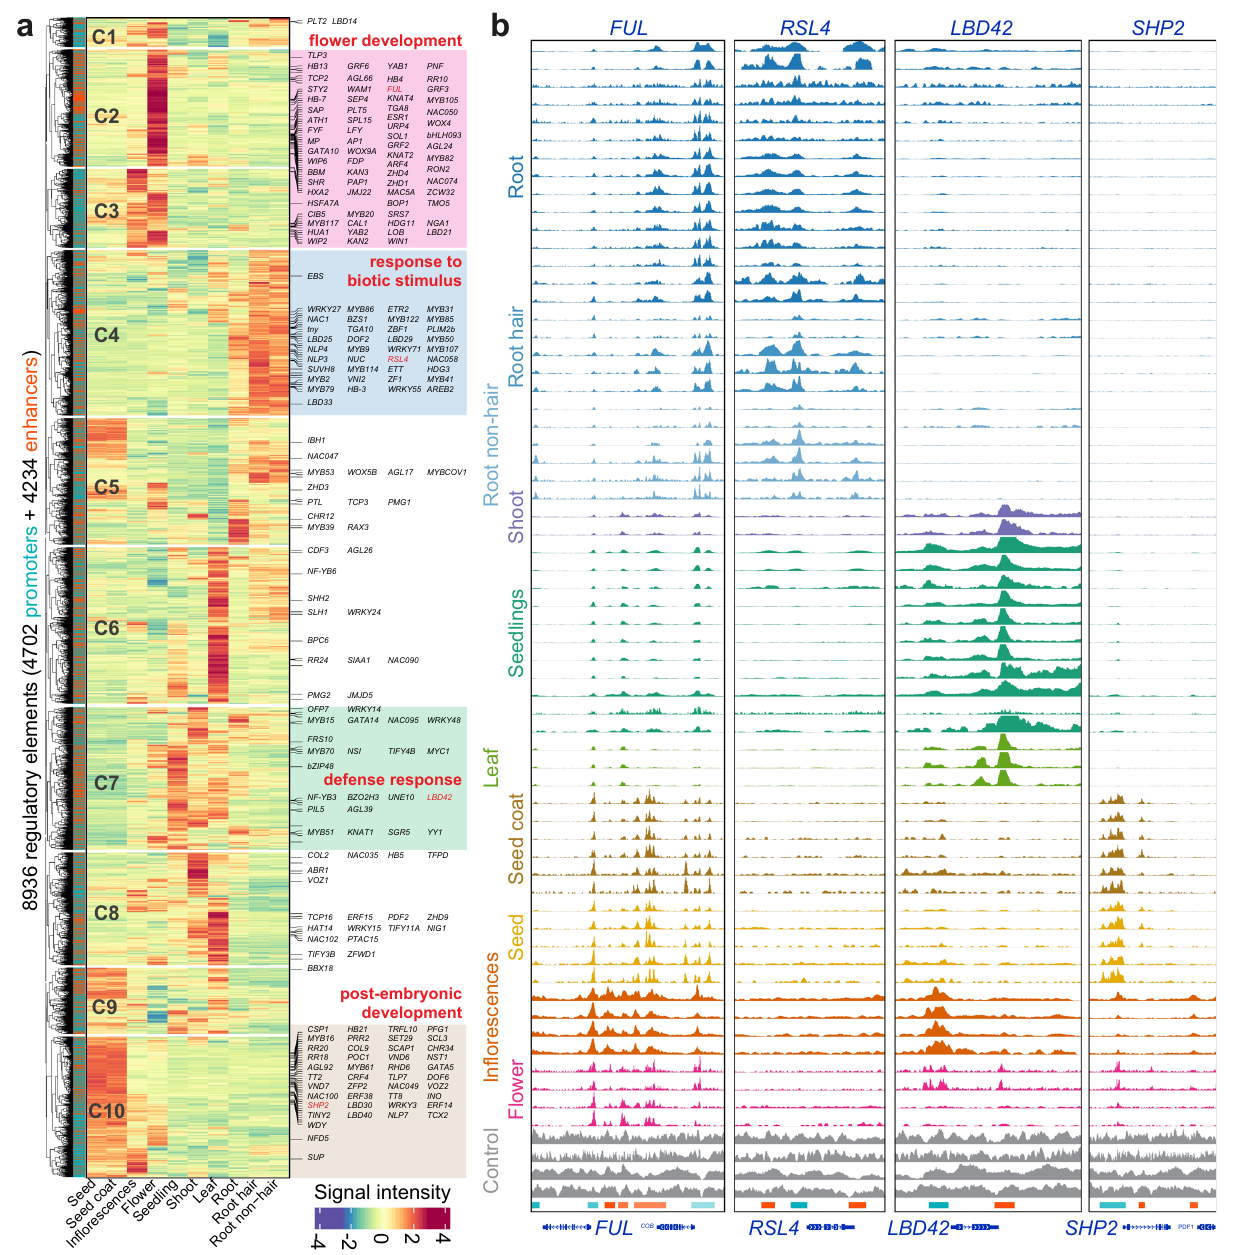
Fig. 5 Dynamic activity of tissue-speci fi c regulatory elements. a Heatmap showing the chromatin accessibility of highly speci fi c regulatory elements (including promoters and enhancers). Regulatory elements are grouped into ten clusters (C1 – C10; the same number of tissues) based on their activity. TF target genes are labeled on the right. Clusters speci fi c to fl ower-, root-, leaf- or seed- related tissues are highlighted. Representative of enriched GO terms for the highlighted clusters are indicated. b Genome browser views of tissue-speci fi c chromatin accessibility at the four chosen gene